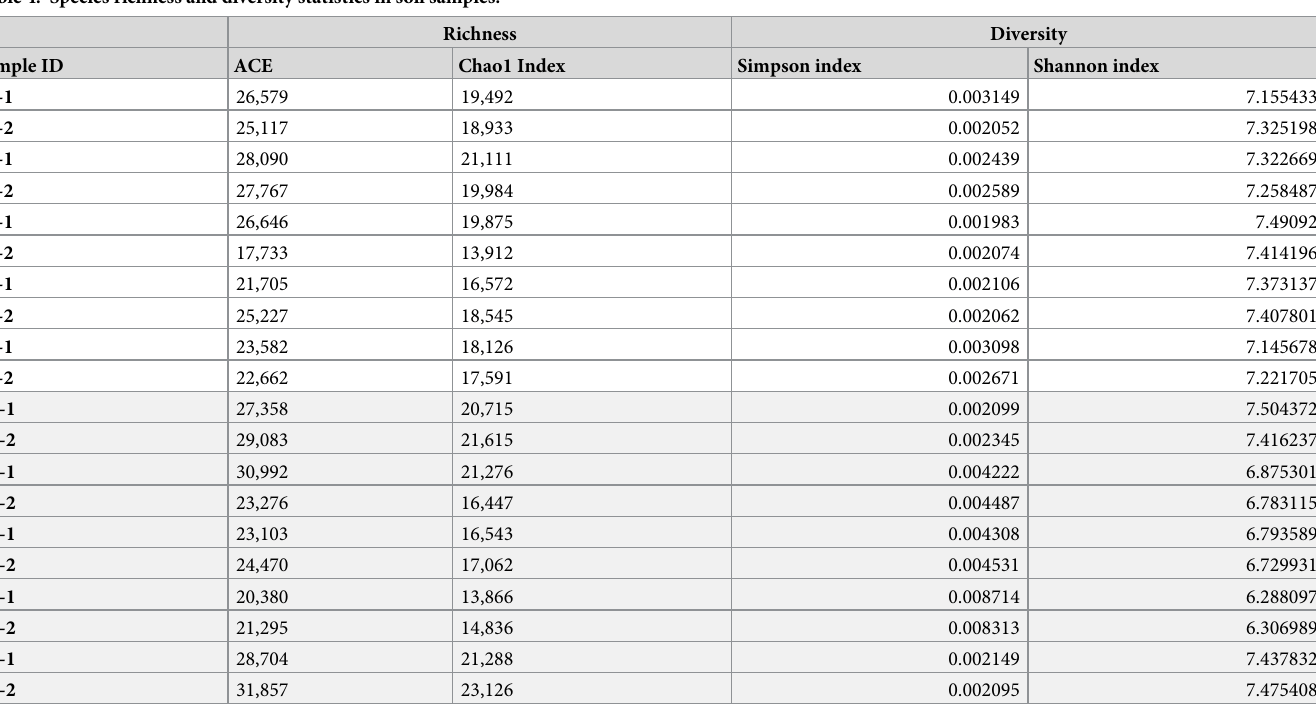
Fig 3. Rarefaction curves of the microbial communities of soil samples derived from conventional (K1-1 – K5-2) and from organic farmsteads (E1-1 – E5-2). Operational taxonomic units (OTU) at a 0.03 distance level. https://doi.org/10.1371/journal.pone.0256969.g003 Table 4. Species richness and diversity statistics in soil